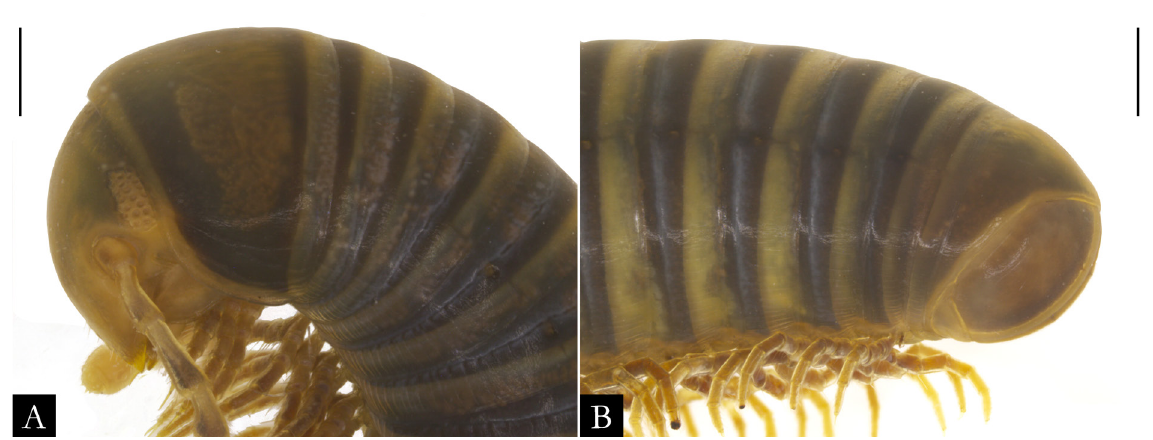
Fig. 74. Pseudonannolene inops Brölemann, 1929, ♂ (IBSP 2559), in lateral view. A . Anterior region. B . Posterior region. Scale bars = 1